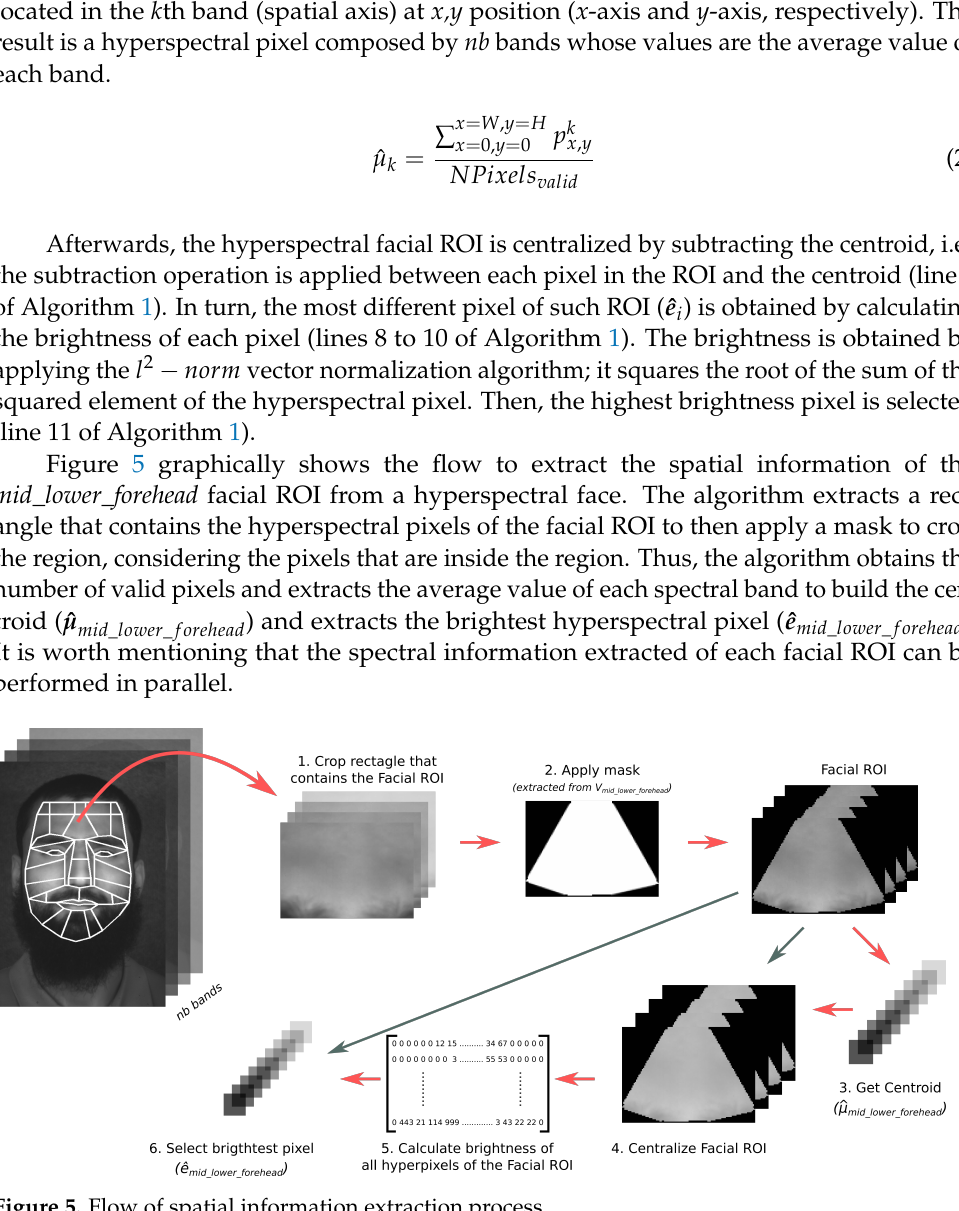
Figure 5. Flow of spatial information extraction